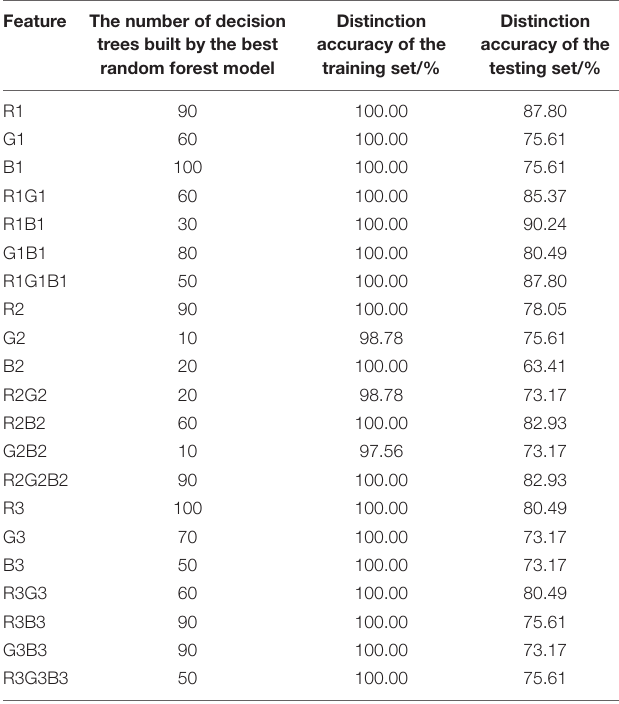
R1 represents the LBP histogram feature of the gray image of the R component of the lesion image filtered by the MB 1 -LBP operator; R2 represents the LBP histogram feature of the gray image of the R component of the lesion image filtered by the MB 2 -LBP operator; R1G1 represents the combination of R1 and G1; the rest features’ implication could be deduced by